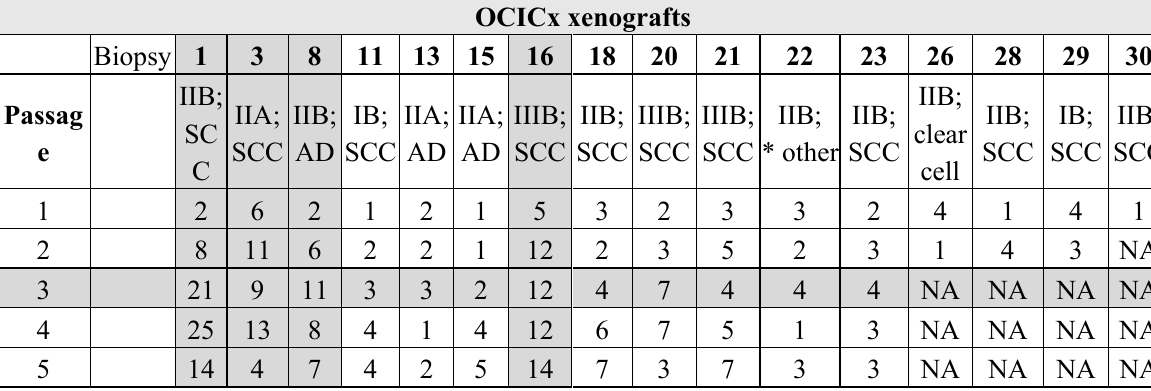
Supplementary Table 1. Patient-derived cervix xenografts (OCICx). A list of 16 OCICx xenografts generated from cervix patient biopsies with details of the clinical background from the patient and tumor grade (SCC = squamous, AD = adenocarcinoma). The